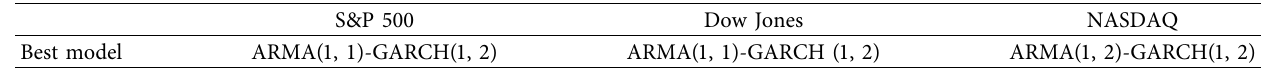
Figure 9: Log-likelihood improvements upon the simple method when the test set is 10%. Table 10: ARMA-GARCH model with minimum BIC when the test set is 20%.